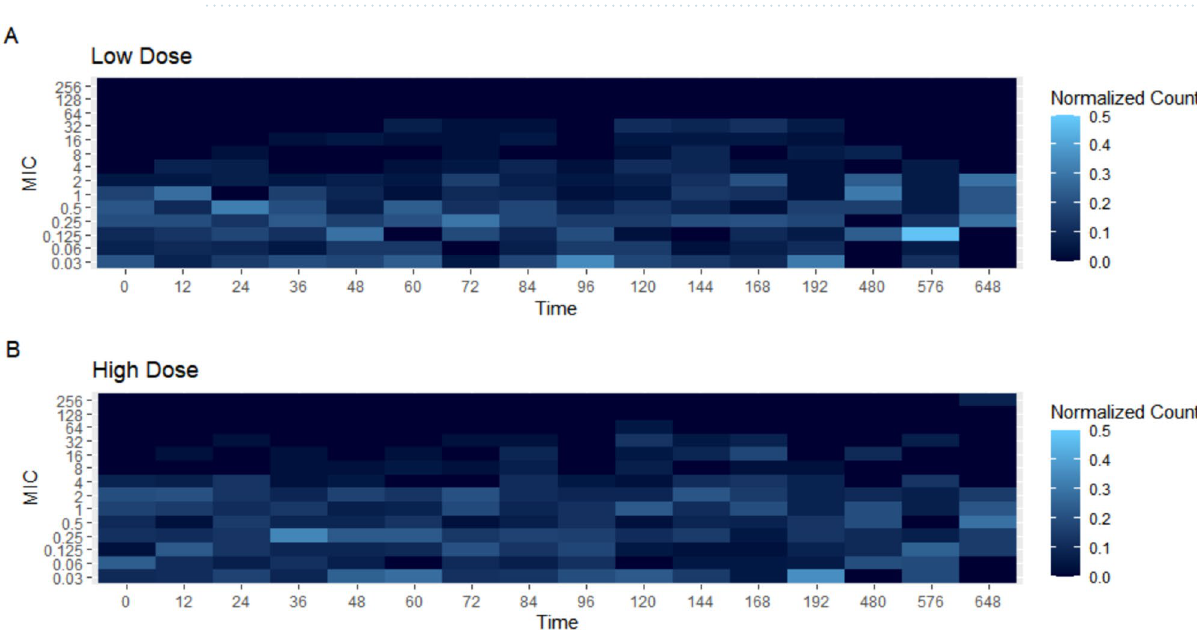
Figure 5. Heat Map demonstrating the number of Enterococcus isolates per each MIC value over time for both the low dose ( A ) and high dose group ( B